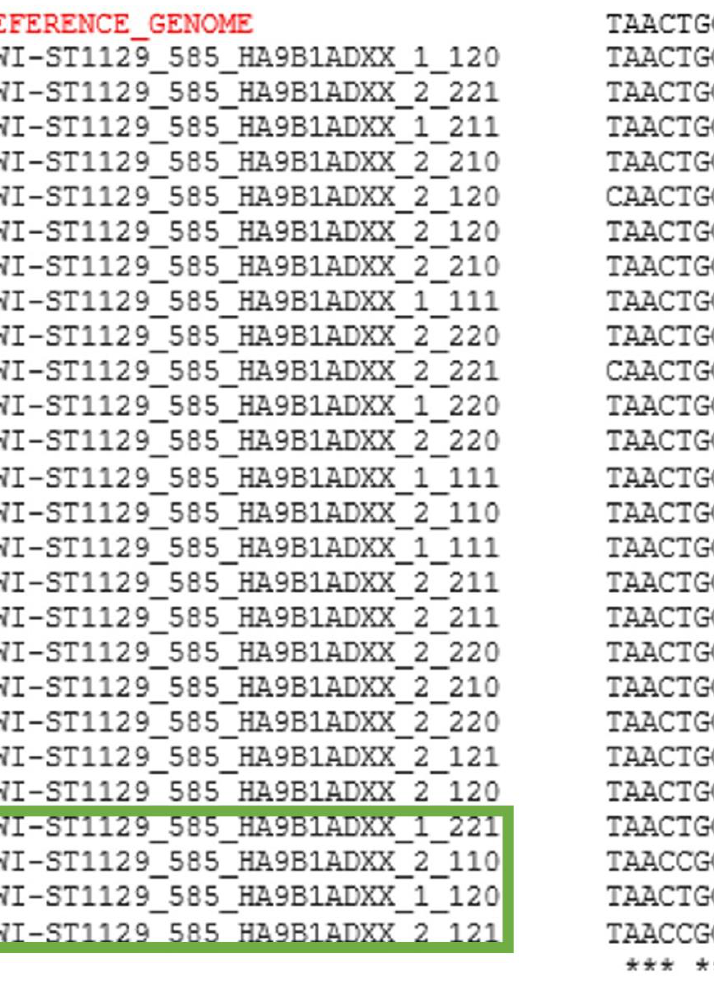
Figure 3. Alignment of RNA-Seq reads to the human genome. Poly(A) selected RNA from two breast cancer cell lines (MCF-7 and MDA-MB-231) were sequenced with an Illumina Hi-Seq to provide high coverage mRNA transcripts. These transcripts were then compared to reference genome (top in red), with mismatches indicating a possible site of editing activity. Here one such site is shown within the red box, with mismatched reads outlined in green. Alignment was generated using ClustalW (http://www.genome.jp/tools-bin/clustalw) [40].